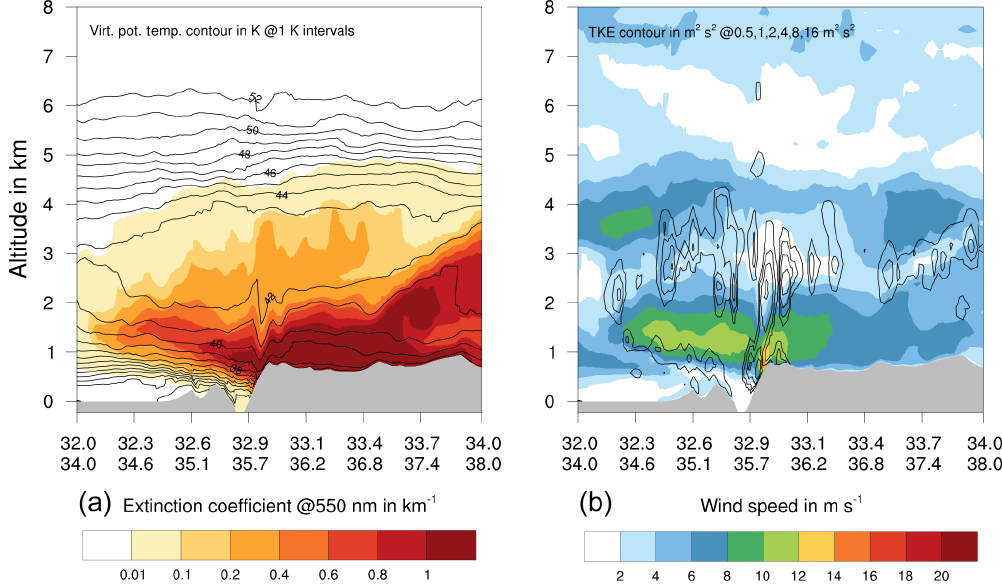
Figure 10. ICON-ART model results along a vertical cross section from 32 ◦ N, 34 ◦ E to 34 ◦ N, 38 ◦ E at 03:00UTC, 8 September. Displayed in panel (a) is the colour-coded extinction coefficient overlaid with virtual potential temperature contours. In panel (b) wind-speed is colour- coded and overlaid with turbulent kinetic energy